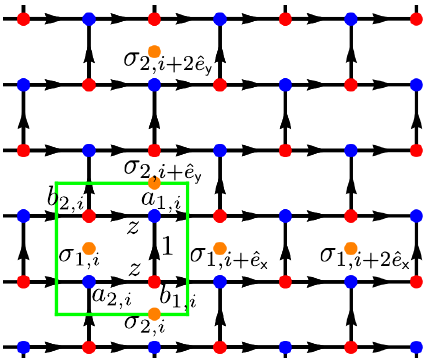
Figure 32: Brick lattice used for calculation of the nearest-neighbour TLIAF spin-spin correlation function in the constrained manifold. The (non-minimal) unit cell contains two spins, σ well as four Grassmann variables, labelled a determined by studying expectation values of pairs of Grassmann variables associated with the inter- mediate